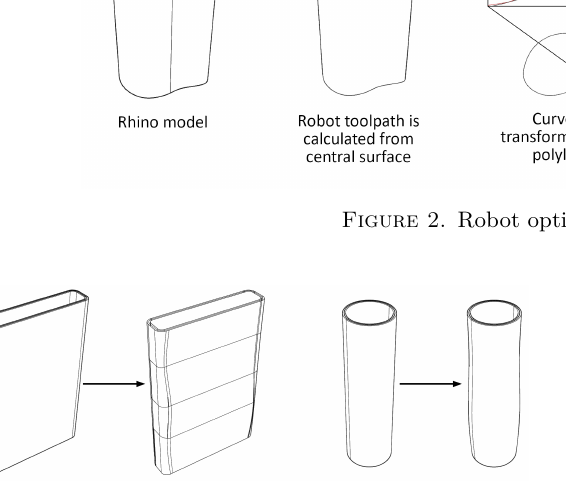
Figure 3. The principle of buckling.